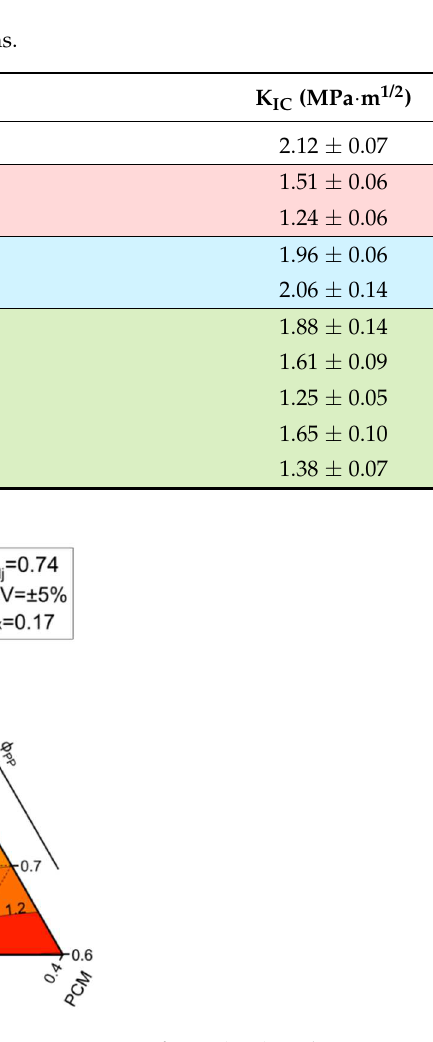
Figure 13. Ternary diagram of the critical stress intensity factor (K IC ) under impact conditions of the prepared